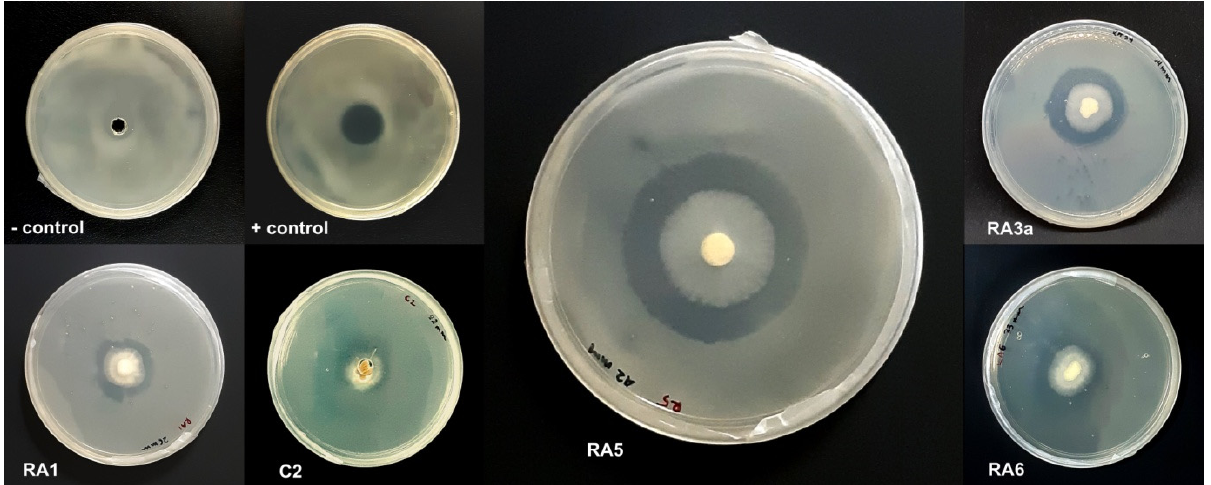
Figure 1. Plate-based growth inhibition assays of E. mallotivora through well diffusion method. All fungal isolates displayed notable growth inhibition zones. Potato dextrose broth (PDB) and kanamycin were used as the negative and positive controls, respectively. Table 2. Antagonistic potential of the Trichoderma isolates against E. mallotivora. The negative ( − ) control consists of 100 µ L of PDB, the positive (+) control of 100 µ L of kanamycin (100 µ